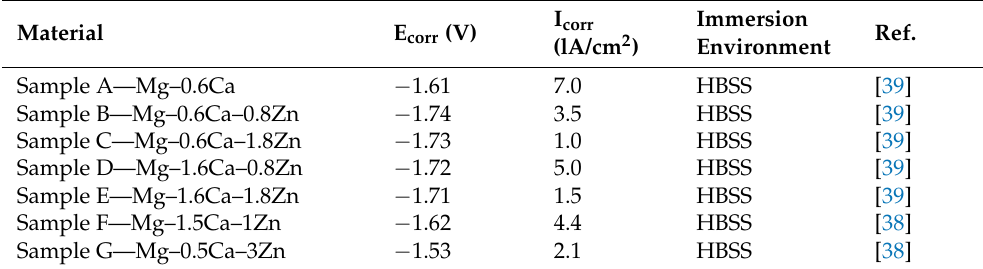
Table 2. Corrosion parameters of some Mg–Ca–Zn biodegradable alloys [38,39]. Material E corr (V)